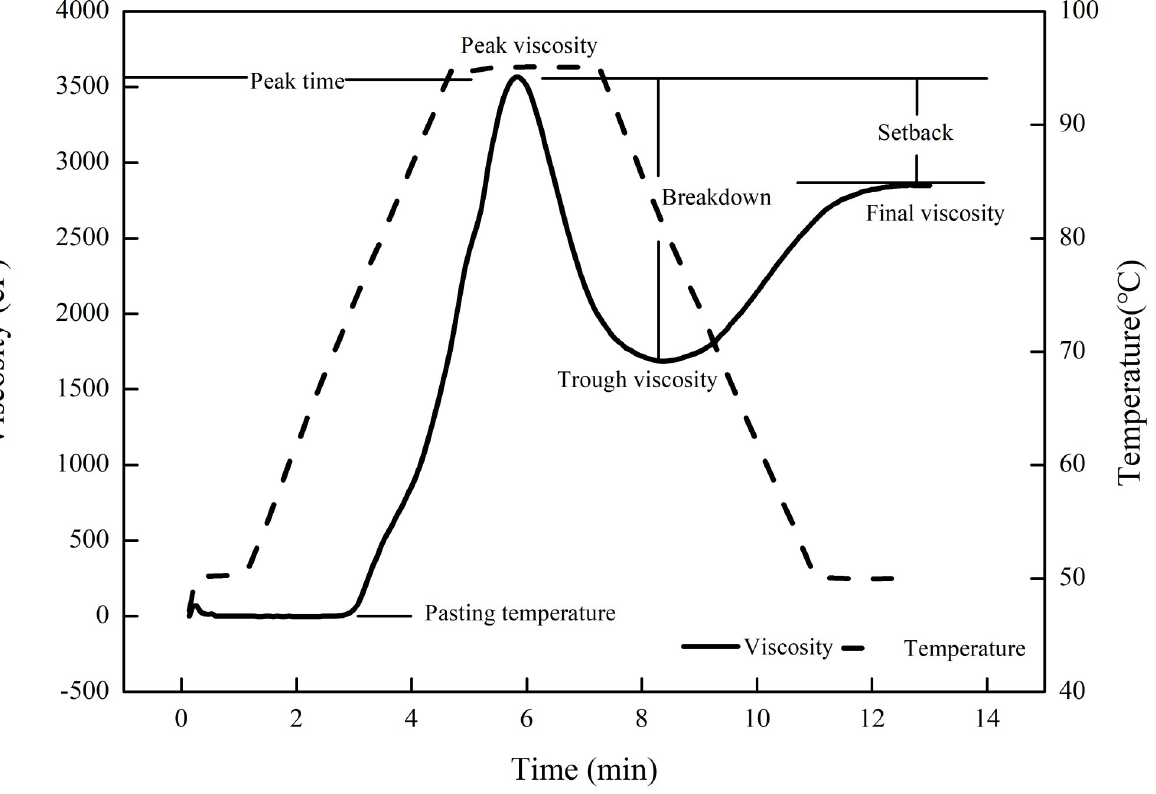
Fig 2. Rapid viscosity analyzer profile of milled rice